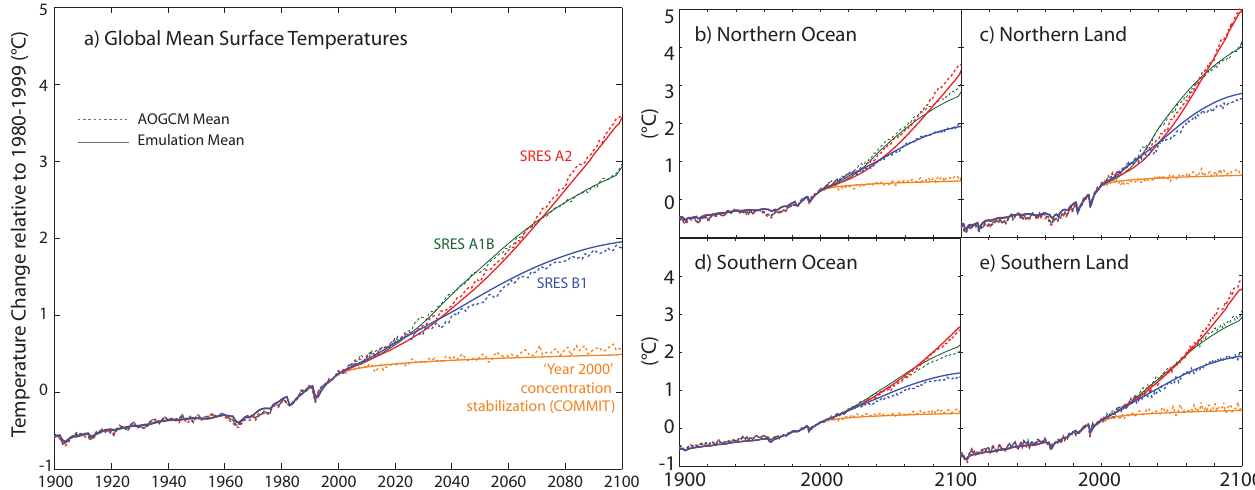
Fig. 4. Comparison of mean surface temperatures as diagnosed from CMIP3 AOGCMs (dashed) and the emulations with MAGICC6 using “like-with-like” forcings and the calibration III method (solid lines, see Sect. 4.2.3). The scenarios shown are SRES A1B (green), B1 (blue) and A2 (red) in addition to the “year 2000 concentration stabilization” (COMMIT) experiment (orange). For the different scenarios, the number of available AOGCM datasets differs, which is taken into account, so that only the mean across the corresponding set of emulations is shown. The land and ocean regions in each hemisphere were determined from the individual AOGCMs’ land-ocean